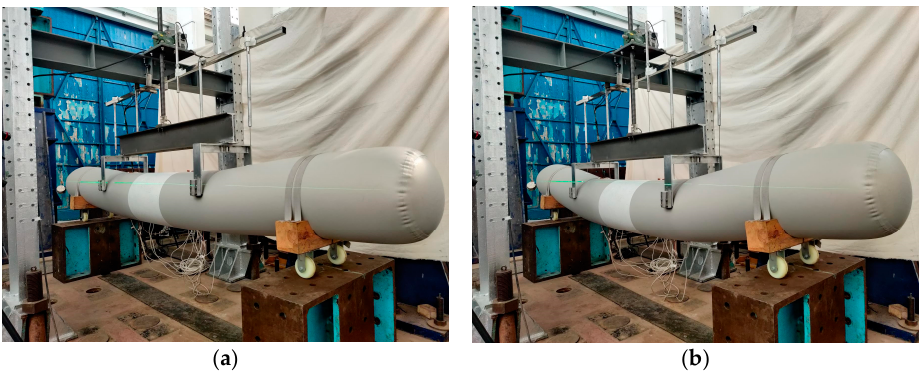
Figure 10. Deflected process of the inflated sample: ( a ) initial loading; ( b ) close to ultimate load.